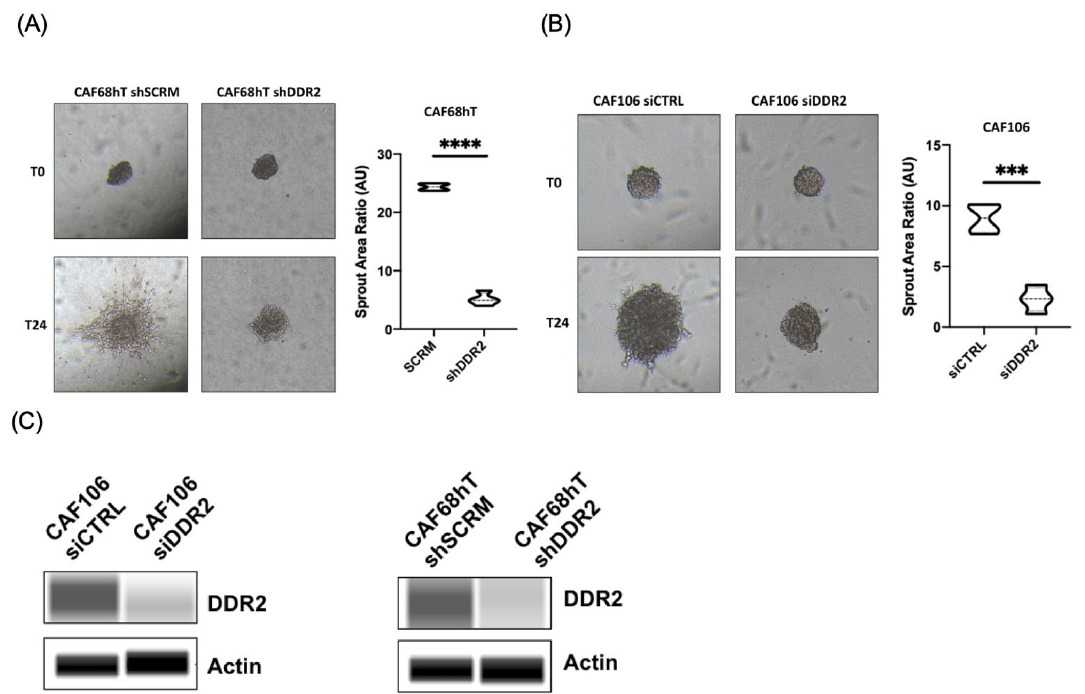
Figure 1. DDR2 depletion in CAFs leads to decreased tumor spheroid spreading using ( A ) CAF68hT in polymerized collagen 1 and ( B ) CAF106 in Matrigel. ( C ) Western blot showing DDR2 knockdown. *** p < 0.001, **** p < 0.0001.